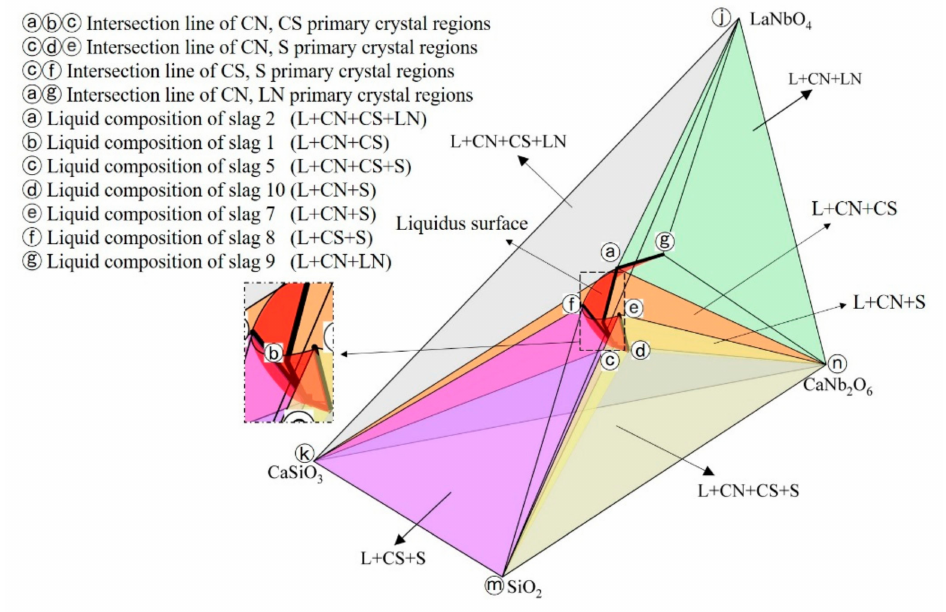
Figure 8. Isothermal phase diagram of CaO-SiO 2 -La 2 O 3 -Nb 2 O 5 system in reducing atmosphere at 1200 ◦